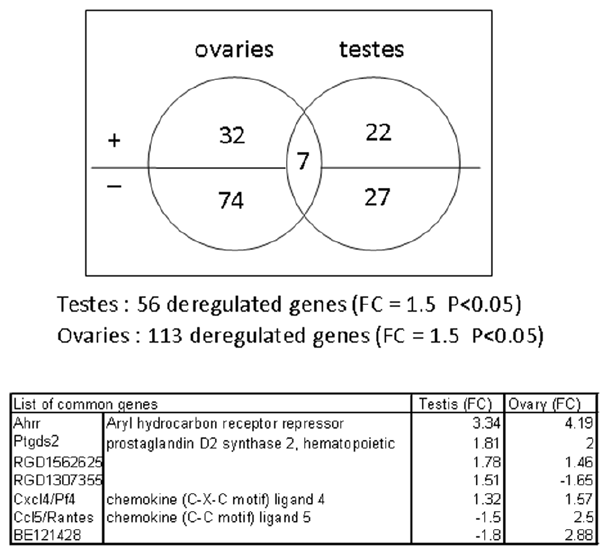
Figure 1. TCDD-regulated genes detected by microarrays in ovaries and testes. Genes were selected on the basis of a p- value , 0.05 and a 1.5 fold change factor of mRNA expression in response to TCDD. The Venn diagram illustrates the repartition between genes up- and down-regulated in testes or ovaries, and the 7 genes both regulated in testes and ovaries are listed. doi:10.1371/journal.pone.0040306.g001 PLoS ONE |